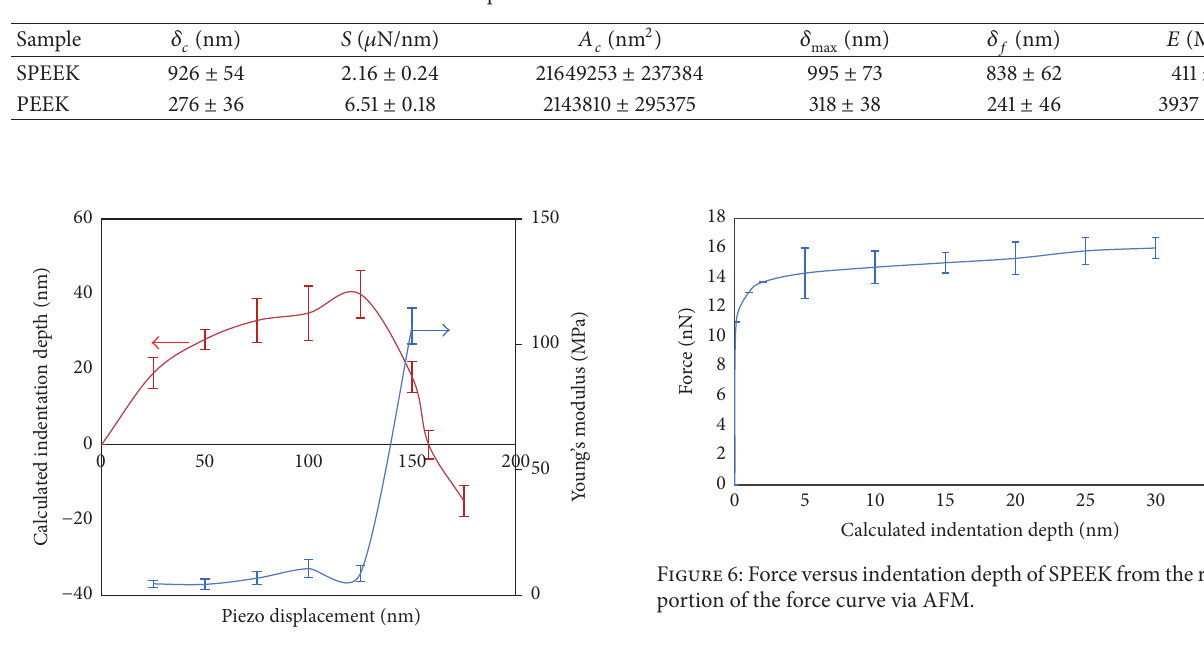
Table 1: The calculated parameter based on the Oliver-Pharr model via the NTS.